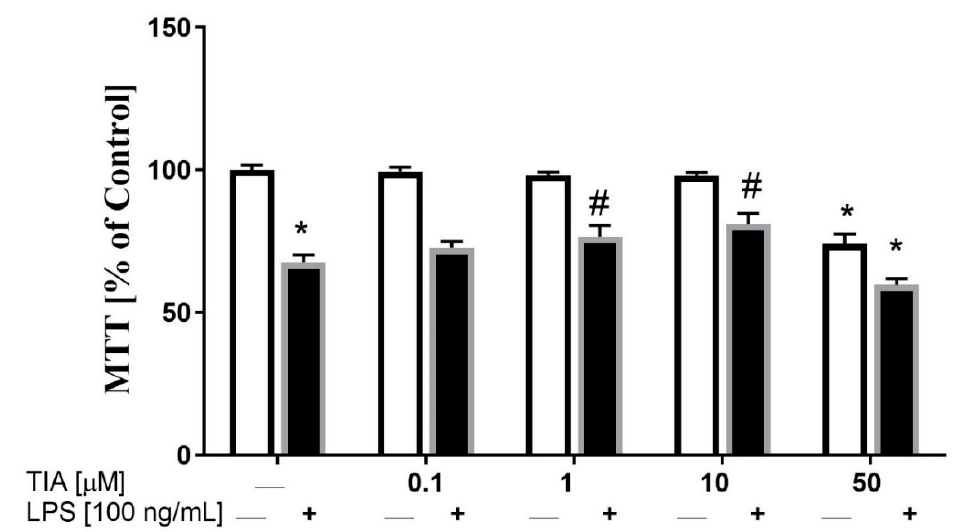
Figure 1. The influence of tianeptine (TIA) on cell viability (tetrazolium salt 3-(4,5-dimethylthiazol-2-yl)-2,5-diphenyltetrazolium bromide, MTT) in vehicle- and lipopolysaccharide (LPS)-treated primary microglial cells. Microglial cells were pretreated with various concentrations of tianeptine (TIA; 0.1, 1, 10, or 50 µ M) for 30 min, and then with lipopolysaccharide (LPS; 100 ng/mL) for 24 h. The data are presented as the mean ± standard error of the mean (SEM) percentage of control (vehicle-treated cells) from independent experiments ( n = 6 in each group). The results were statistically evaluated using two-way analysis of variance (ANOVA) with a Duncan post-hoc test to assess the differences between the treatment groups. Significant differences from the control group (vehicle-treated cells) are indicated by * p < 0.05; differences between LPS-treated groups and pre-treated with tianeptine and then stimulated with LPS groups are indicated by # p < 0.05.